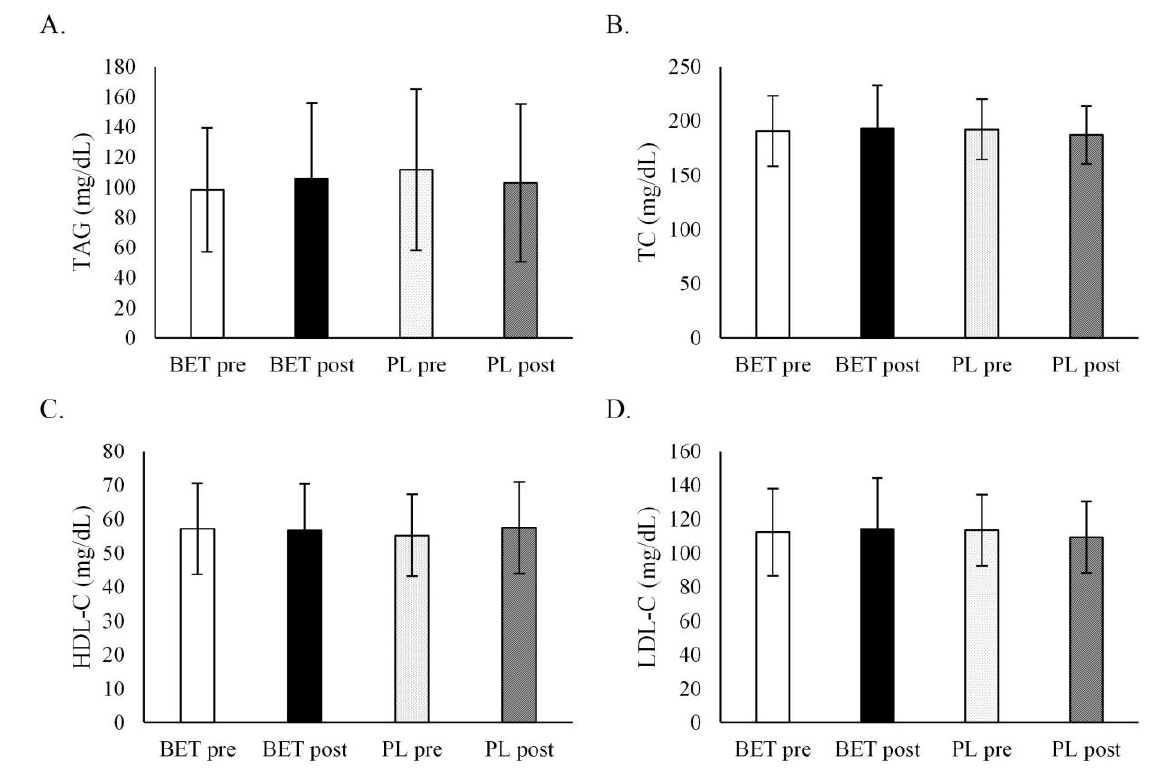
Figure 3. The effect of betaine supplementation on blood lipids concentrations. ( A ). The effect of betaine supplementation on triacylglycerol concentration. ( B ). The effect of betaine supplementation on total cholesterol concentration. ( C ). The effect of betaine supplementation on HDL cholesterol concentration. ( D ). The effect of betaine supplementation on LDL cholesterol concentration. BET post , after betaine supplementation; BET pre , before betaine supplementation; HDL-C, high-density lipoprotein cholesterol; LDL-C, low-density lipoprotein cholesterol; PL post , after placebo supplementation; PL pre , before placebo supplementation; TAG, triacylglycerol; TC, total cholesterol. BET had no influence on inflammatory cytokine concentrations (Table 5, Figure 4).